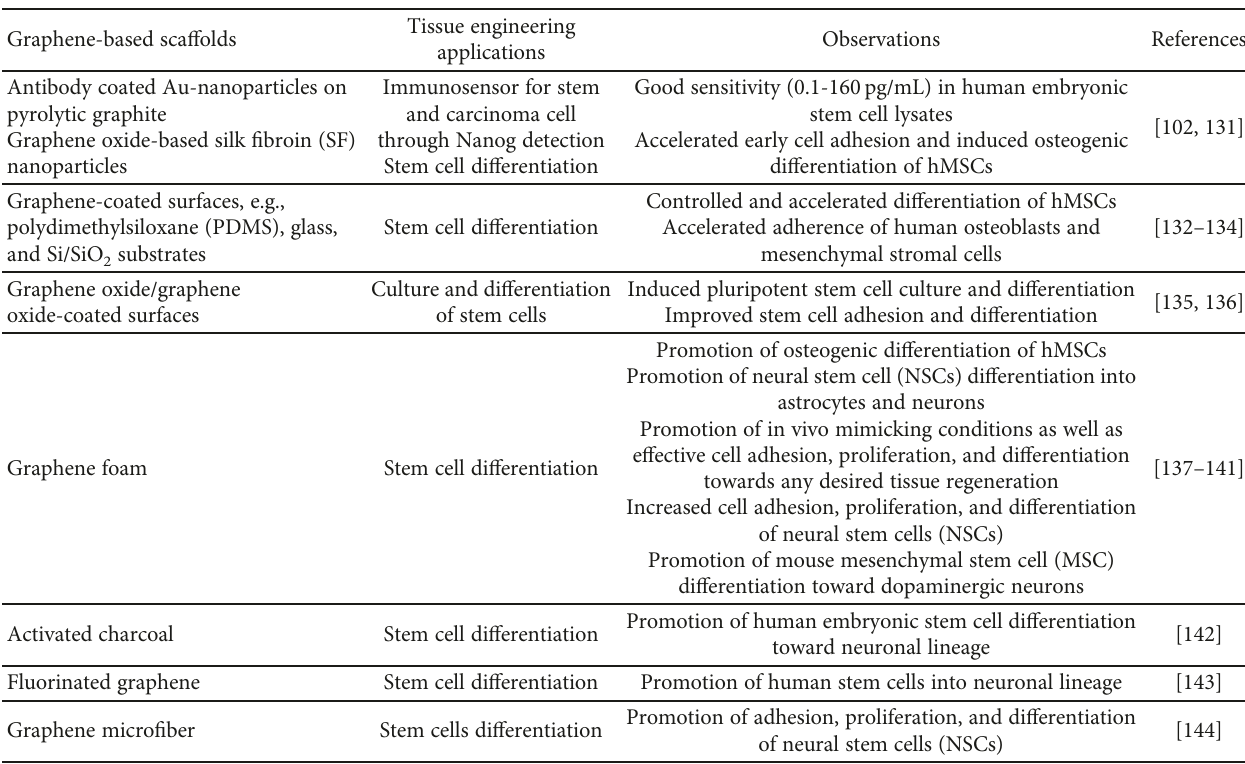
Table 1: Graphene-based sca ff olds for tissue engineering